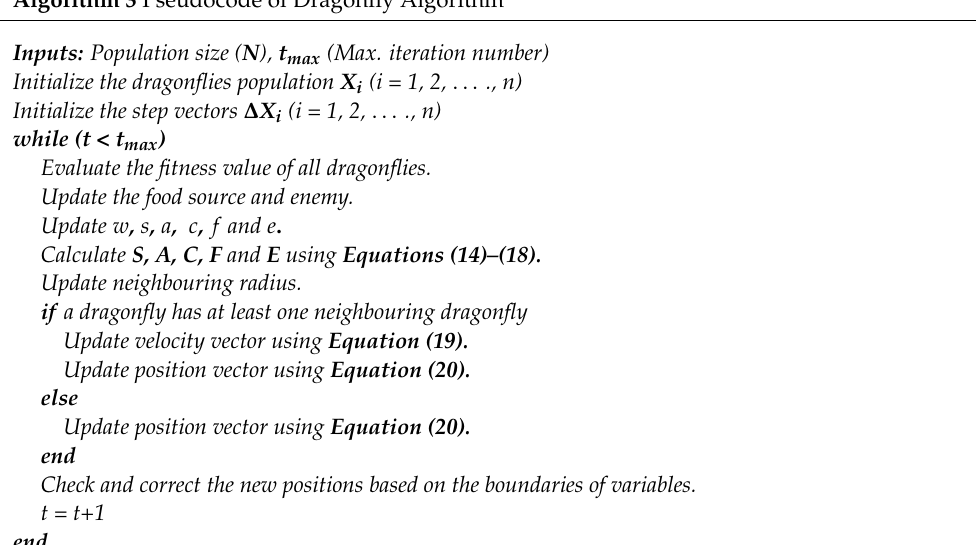
Algorithm 3 Pseudocode of Dragonfly